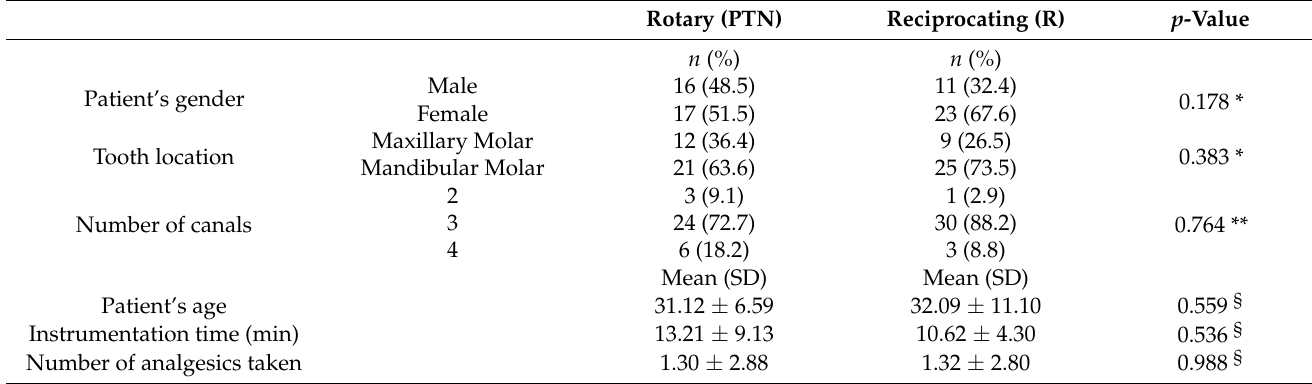
Figure 1. PRIRATE 2020 flow diagram showing the number of patients included in the clinical trial and the main details of the study [22]. Table 1. Baseline demographic and clinical features (patient and tooth-related factors) of patients in the study